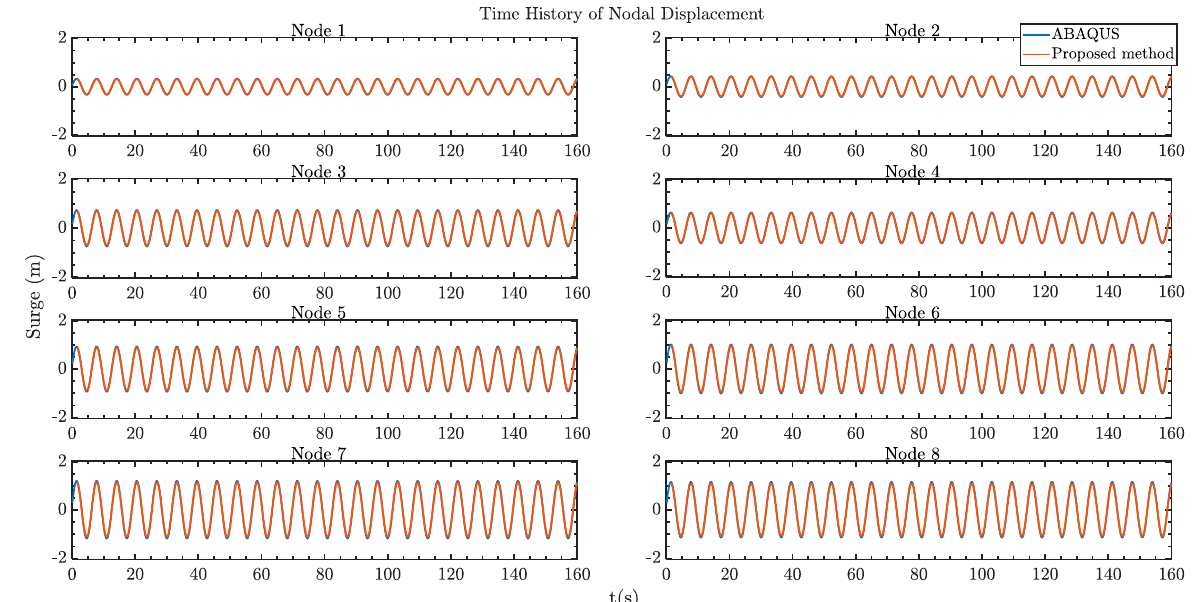
Figure 8. Comparison of the time history of nodal displacement in surge under regular wave excitations.